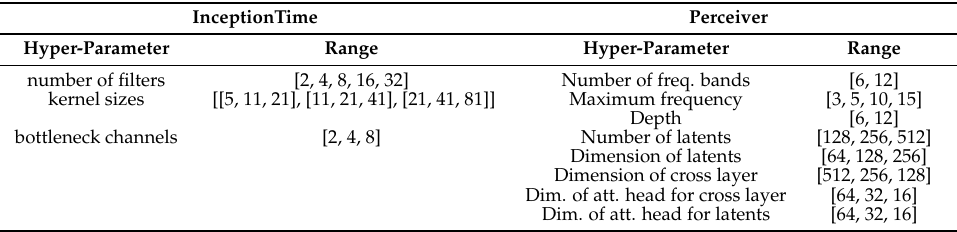
Table 3. Hyper-parameter ranges of deep feed-forward